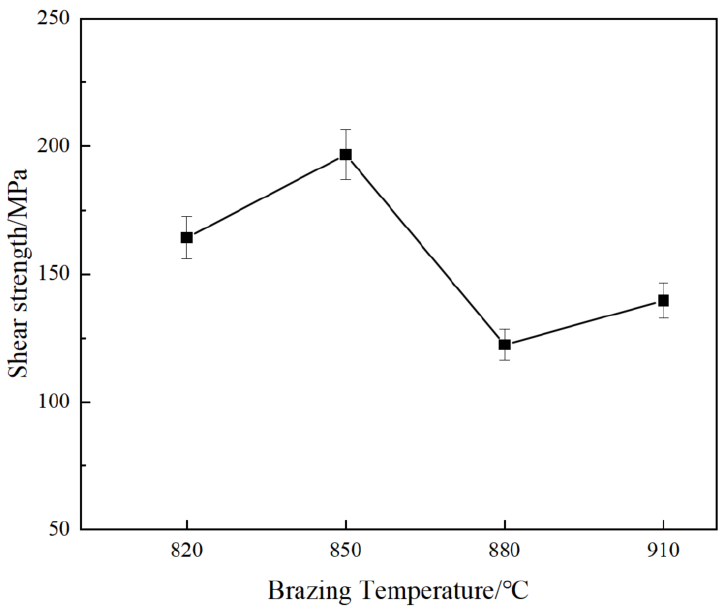
Figure 10. Shear strength of the GH4169/Si 3 N 4 joint brazed at different parameters.